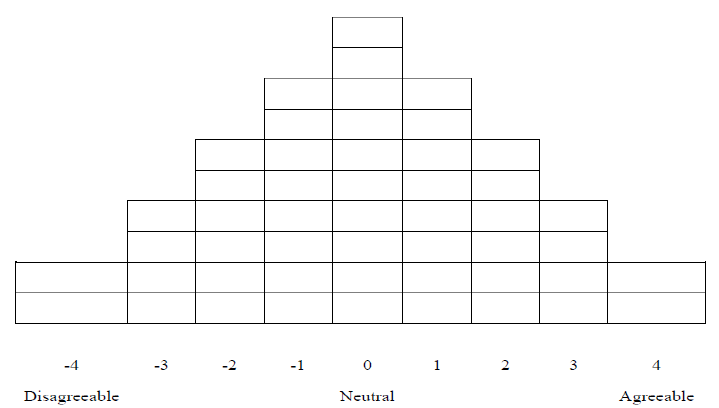
Figure 1. Card arrangement distribution table.